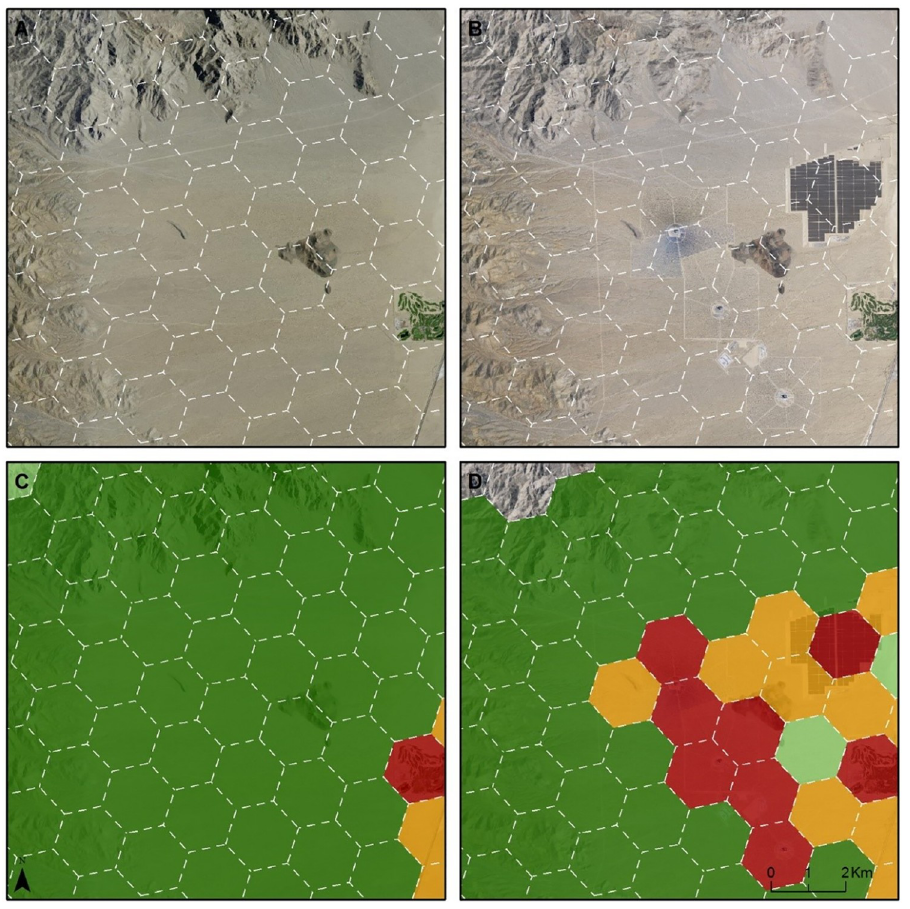
Fig 3. One Example of change in conservation value in Ivanpah Valley Due to solar energy development. A: 2009 imagery; B: 2016 imagery; C: Conservation Value in 2009; D: Conservation Value in 2017. The four colors shown on maps C and D (dark green, light green, orange, and red) correspond with the conservation value categories defined in Table 2.